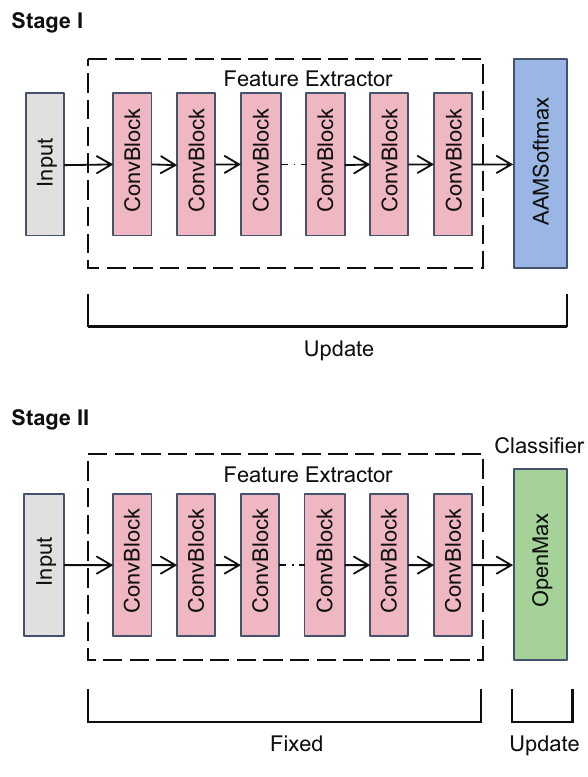
Figure 3. The training stages of the proposed framework. First, the feature extractor is trained by AAMSoftmax. Then, the OpenMAX classifier is updated with the fixed feature